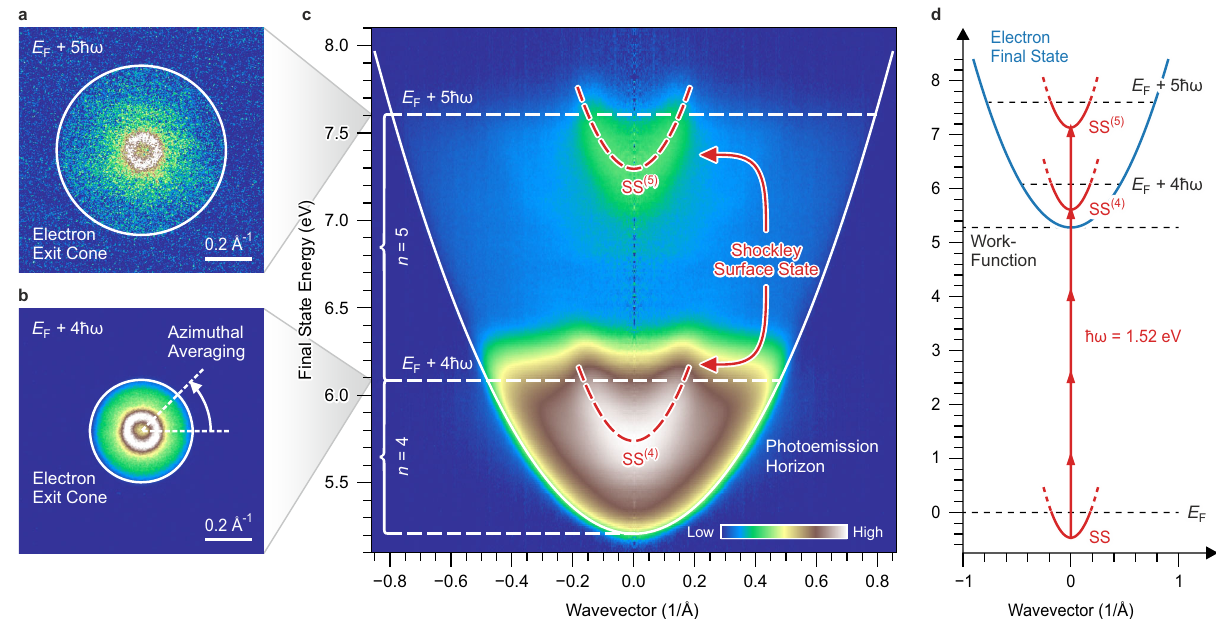
Fig. 2 Angle-resolved plasmoemission spectroscopy. a , b Momentum maps at 5 ℏ ω and 4 ℏ ω above the Fermi energy ( E F ), corresponding to 4 th ( n = 4) and 5 th ( n = 5) order electron emission, respectively, with the photon energy ℏ ω = 1.52 eV. The electron yield is depicted in a linear false color scale (see color bar in panel c ). c Angle-resolved plasmoemission spectrum extracted from the full three-dimensional data stack via azimuthal averaging. The data is presented in a logarithmic false color scale (see color bar in panel c ). The Shockley surface state (SS) is visible in 4 th (SS (4) ) and 5 th (SS (5) ) order electron emission. d Sketch of the electron emission